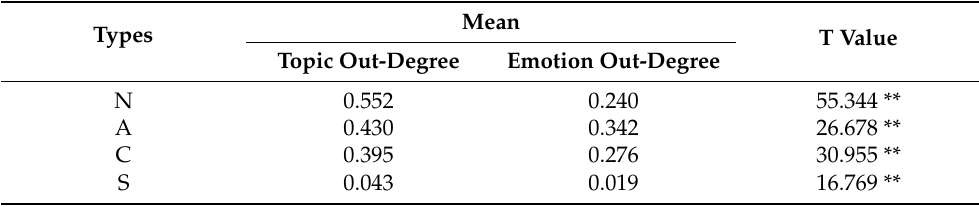
Table 6. The paired sample T-test of topic out-degree and emotion out-degree.